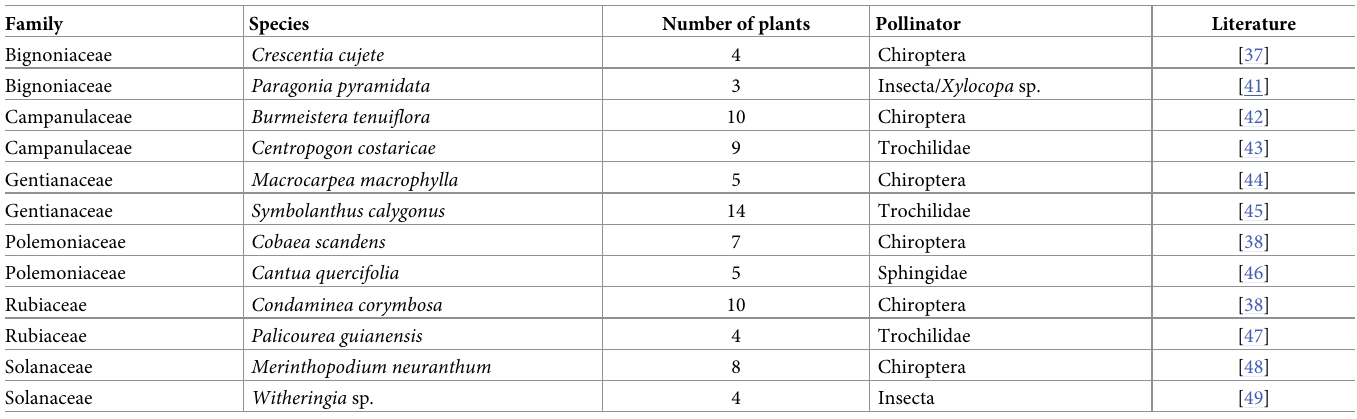
Table 1. Plant families, species, number of individual plants the flowers were collected from and the corresponding pollinators described in the literature. For each of the species we collected 14 individual flowers. Family Species Number of plants Pollinator Bignoniaceae Bignoniaceae Paragonia pyramidata